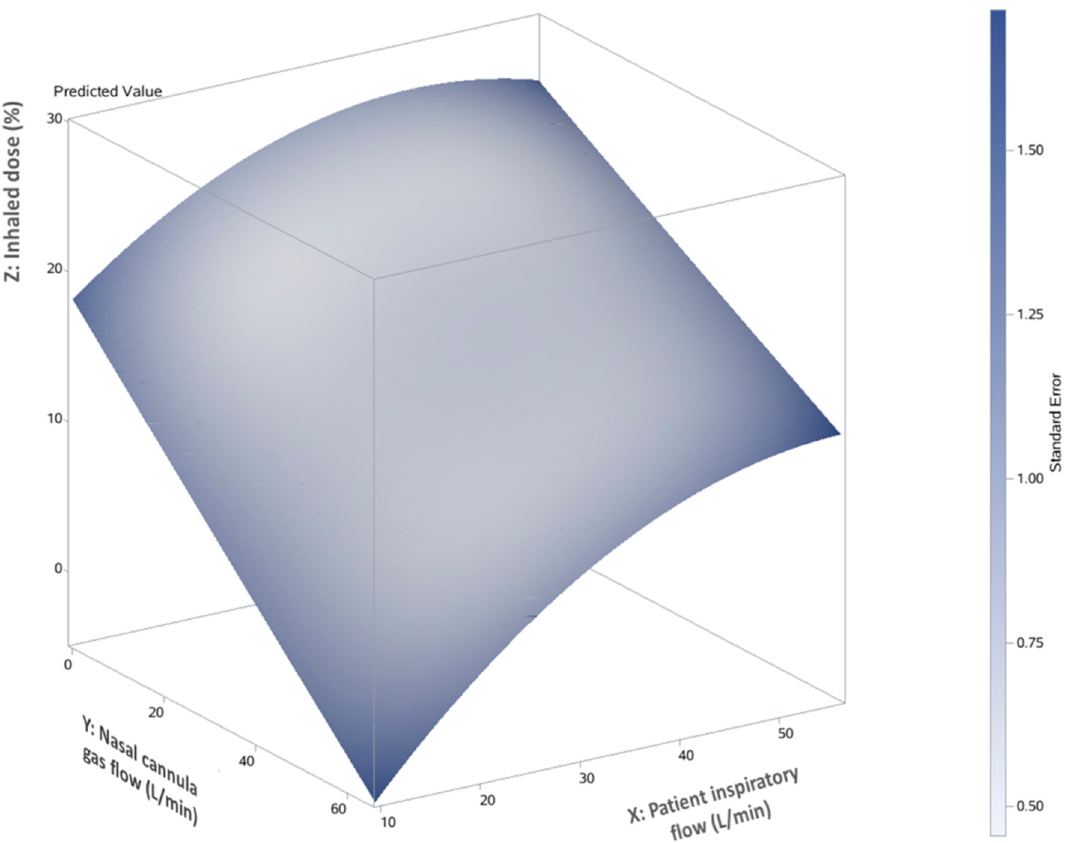
Figure 3. 3D response surface and predicted inhaled dose with nasal cannula flow and patient inspiratory flow.